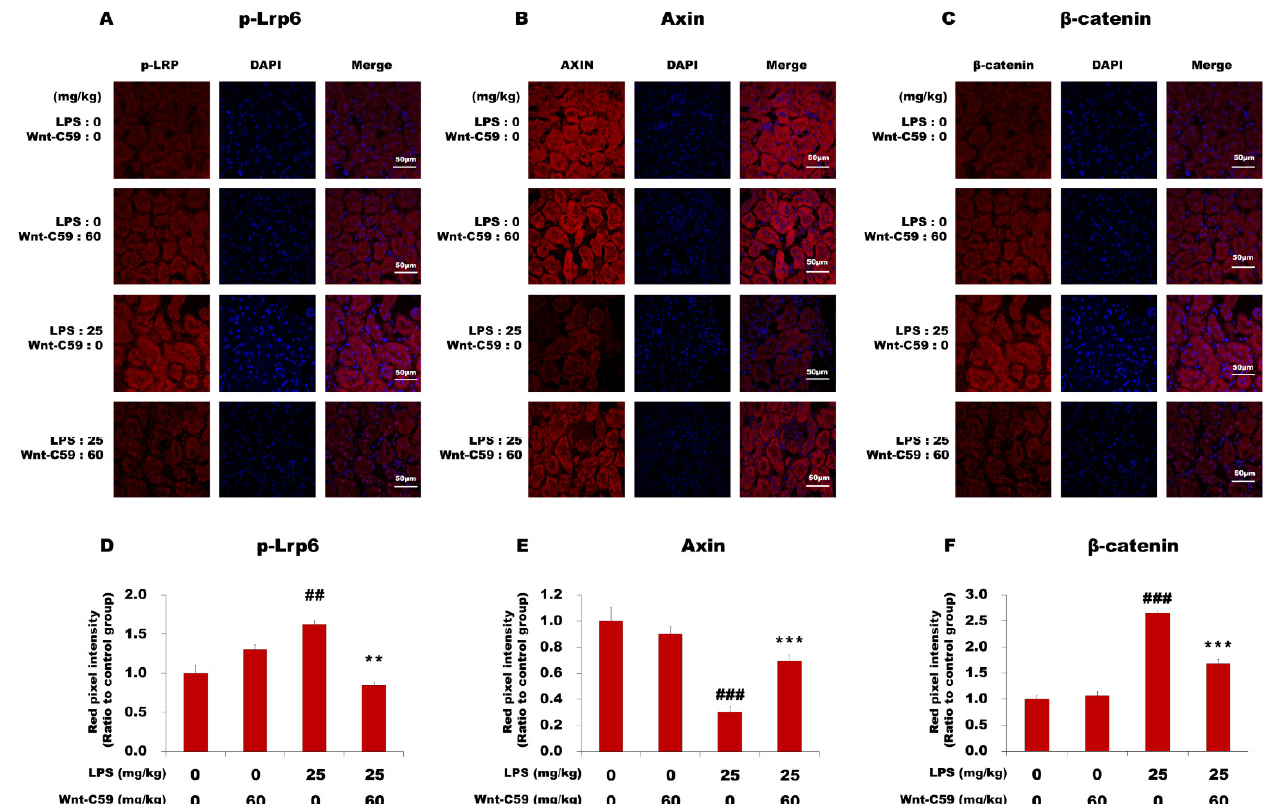
Figure 4. Immunofluorescence analysis of the major proteins in the Wnt/ β -catenin pathway in the kidney. C57BL/6 mice were i. p. injected with 0 or 60 mg/kg of Wnt-C59 and then with 0 or 25 mg/kg of lipopolysaccharide (LPS) after 2 h. ( A – C ) Confocal microscopic images of kidney sections immunostained for p-Lrp6, Axin, or β -catenin were taken at 100 × magnification, respectively. A white scale bar of 50 µ m is shown in each image. ( D – F ) The fluorescence signals in the images were quantified using ImageJ (NIH, Bethesda, MD, USA). ** p < 0.01 and *** p < 0.001 compared with the group injected with 25 mg/kg of LPS. ## p < 0.01 and ### p < 0.001 compared with the control group (unpaired t -test).